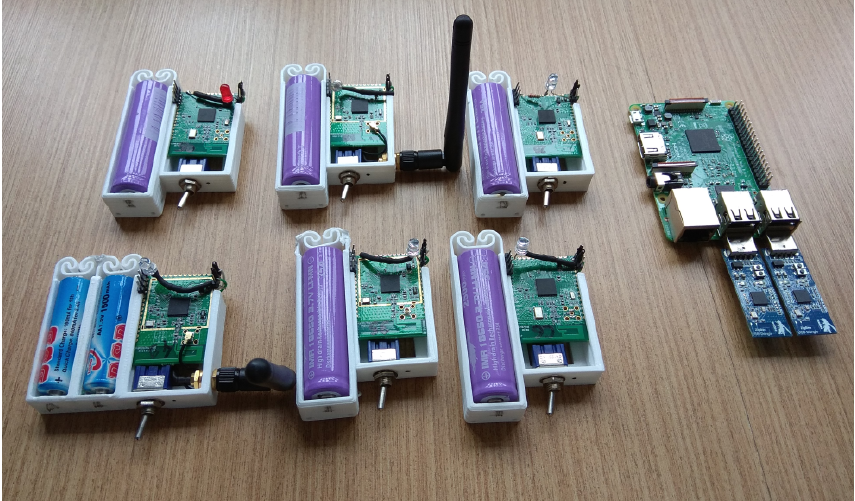
Figure 13. Test bed for the SD6WSN